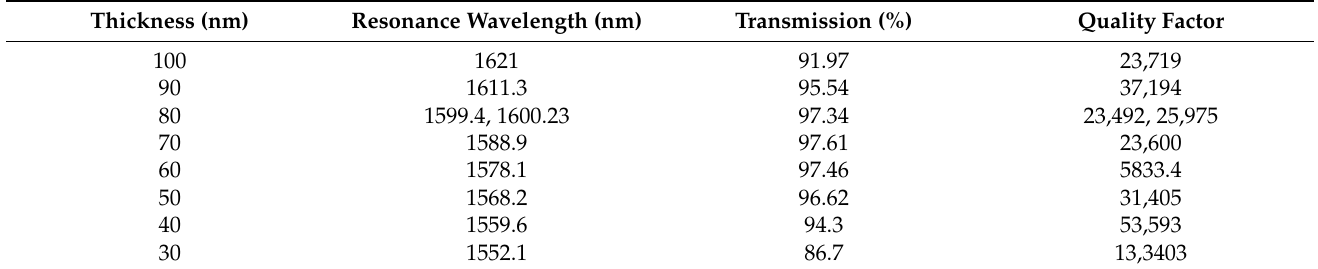
Table 1. The progression of the spectral resonant frequency, quality factor, and transmittance proper- ties of dimer PhC as a function of gap thickness T